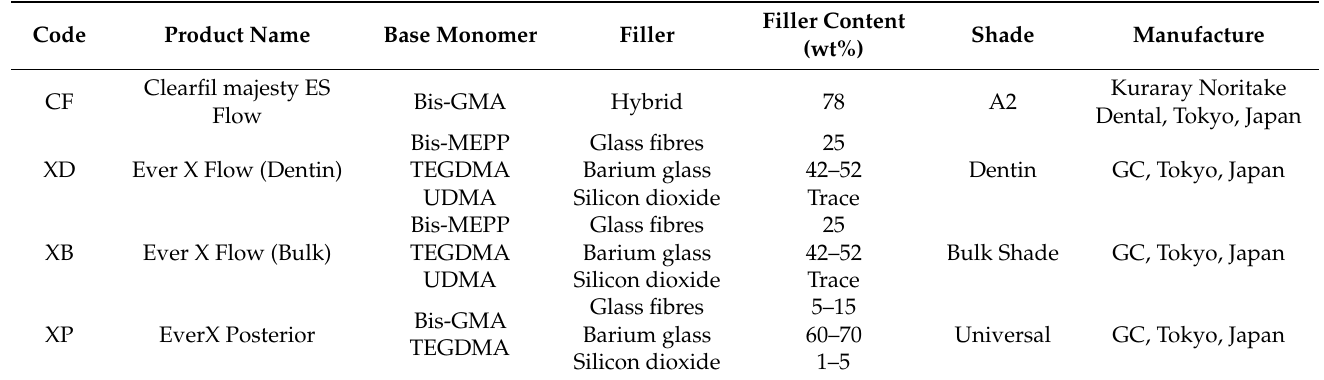
Table 1. Composite resins used in this